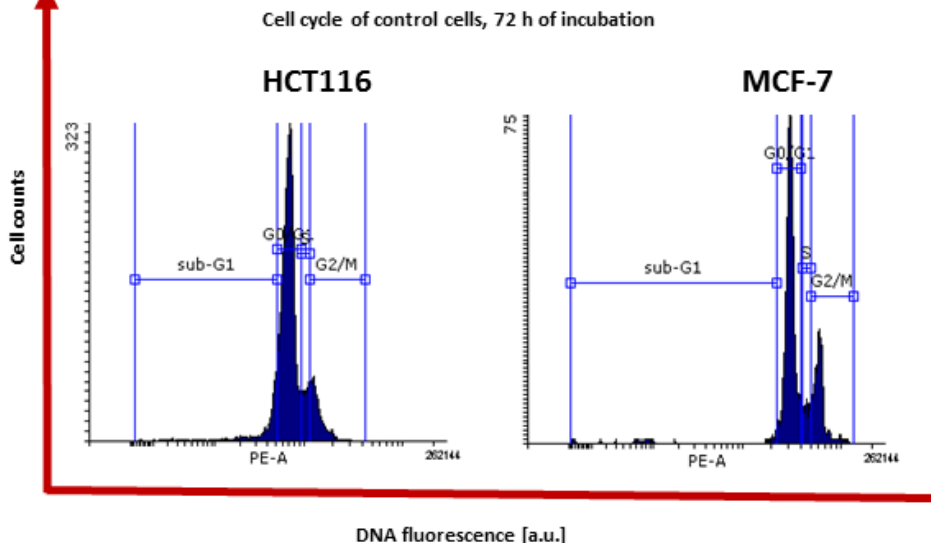
Figure 2. Cell cycle distribution in control HCT116 ( left ) and MCF-7 ( right ) cells after 72 h of incubation. DNA stained with PI [100 µ g/mL] showed cells in cell cycle phases: subG1 (with the lowest content of DNA, <2n); G0/G1 (2n); S (>2n) and G2/M (4n).